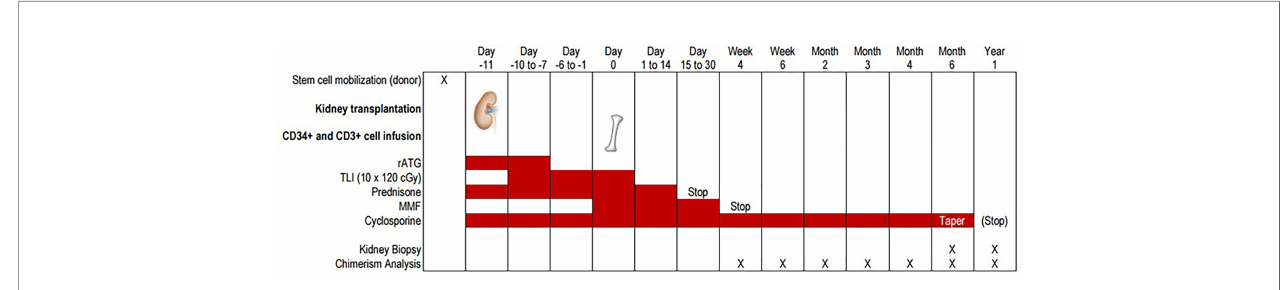
FIGURE 1 | Overview over the trial protocol. Schematic overview over the trial protocol showing the timing of kidney and hematopoietic stem cell transplantation, immunosuppressive medication and monitoring with peripheral blood chimerism analyses and allograft